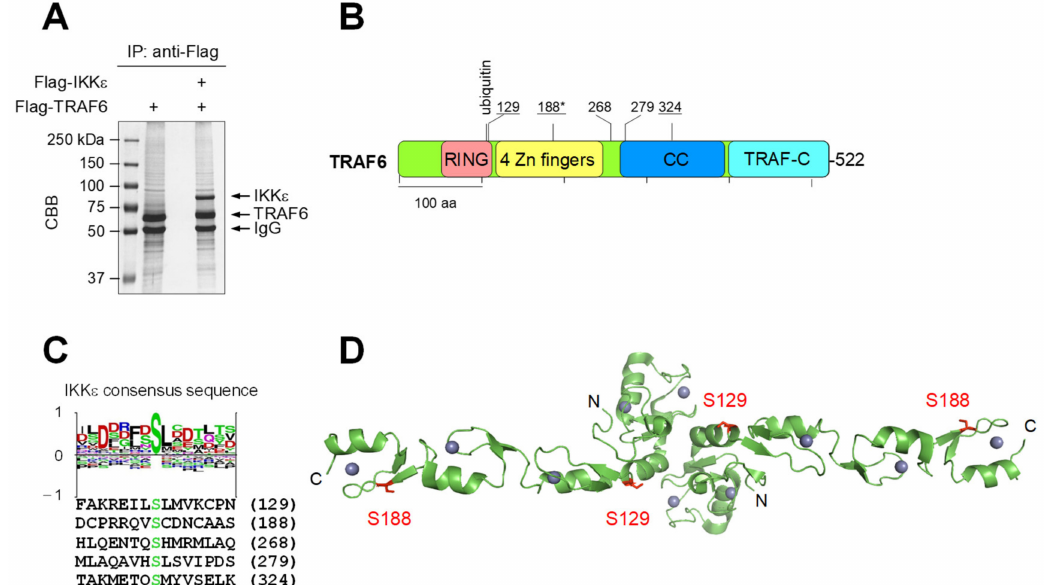
Figure 2. Mapping of IKK ε -mediated TRAF6 phosphorylation sites. ( A ) HEK293T cells were used to express Flag- tagged forms of IKK ε and TRAF6, as shown. Native extracts were produced and Flag-tagged proteins were purified by immunoprecipitation using anti Flag antibodies. One aliquot of the immunoprecipitated material was analyzed by SDS-PAGE and Coomassie brilliant blue (CBB) staining; the positions of molecular weight markers are indicated. The remaining material was used for SDS-PAGE, followed by excision of TRAF6 and mass spectrometric identification of TRAF6 phosphorylation sites. ( B ) Domain organization of TRAF6: RING = Really Interesting New Gene, Zn finger = zinc finger, CC = coiled coil region, TRAF-C = conserved C-terminal TRAF domain. The position of the phosphorylated serines identified via mass spectrometry are shown, the asterisk (*) indicates a known phosphorylation site, and the underlined residues are conserved in mouse TRAF6. ( C ) The sequences around the identified modification sites are listed and compared to the IKK ε consensus phosphorylation sequence logo (deduced from 106 different input sequences) from the PhosphoSitePlus ® database. ( D ) The positions of TRAF6 phosphorylation sites on regions with available structural information are shown. The crystal structure showing the dimeric N-terminal domains of TRAF6 representing amino acids 54–210 (PDB code: 3HCS) was used to highlight the positions of two phosphorylated amino acids in red using